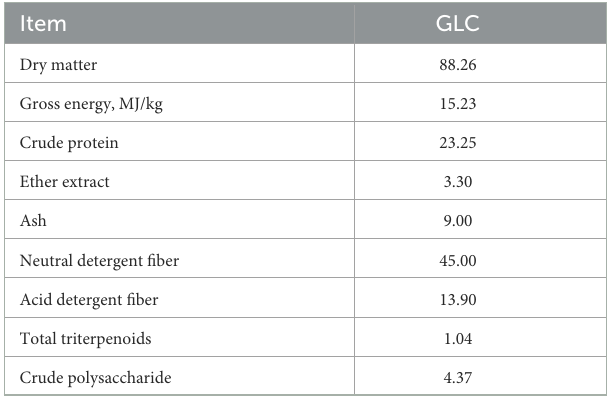
TABLE 1 Analyzed chemical compositions of Ganoderma lingzhi culture (GLC;